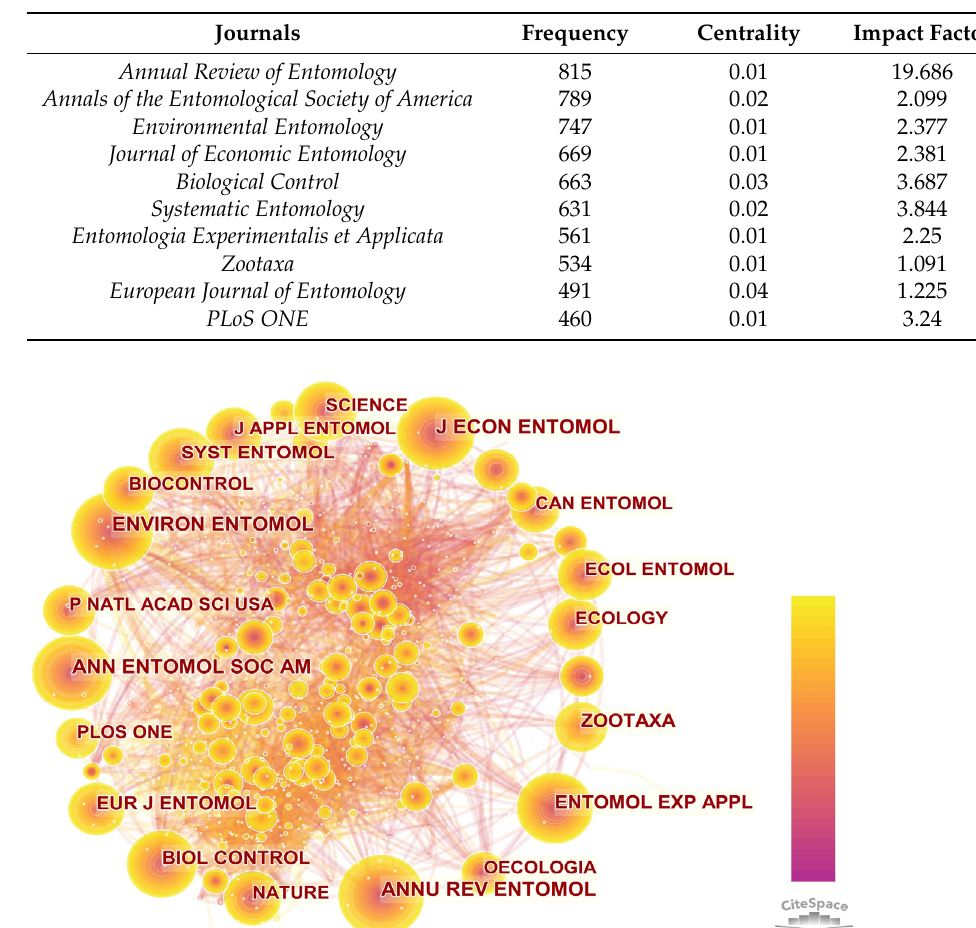
Figure 5. Journal co-citation network. The node size represents the co-citation frequency of each journal, and the connection line between nodes represents co-citation relationships. Table 4. Top 10 journals based on cited frequency.